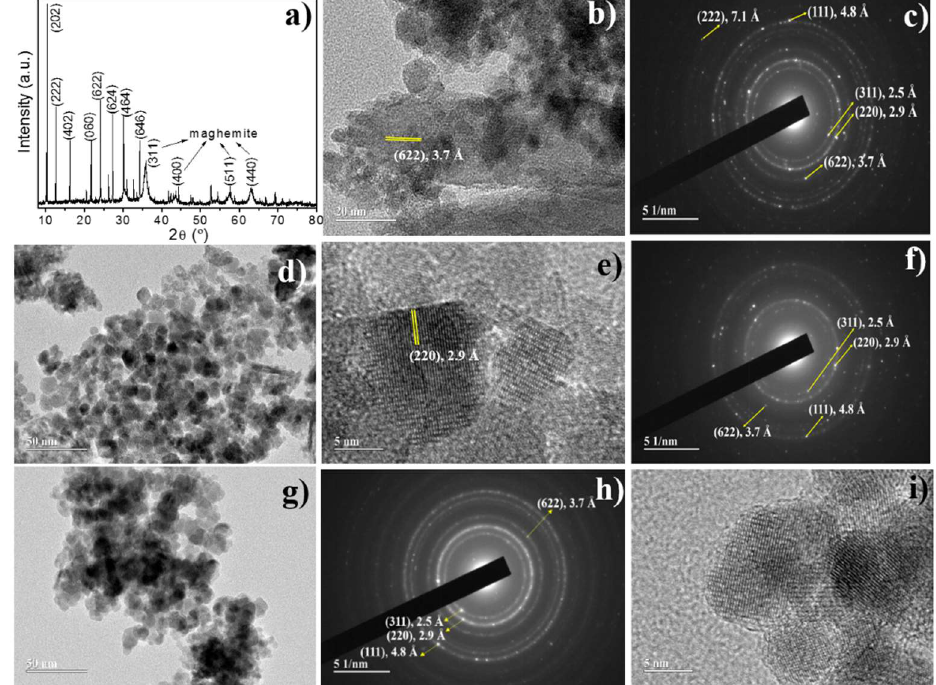
Figure 2. XRD pattern for the NPZEO3 composite, where the Miller indices are also indicated ( a ). Transmission electron microscopy (TEM) images for the NZPEO1 ( b ), NPZEO2 ( d,e ), NPZEO3 ( g,i ), and their respective selected area electron diffraction (SAED) patterns ( c,f,h ).